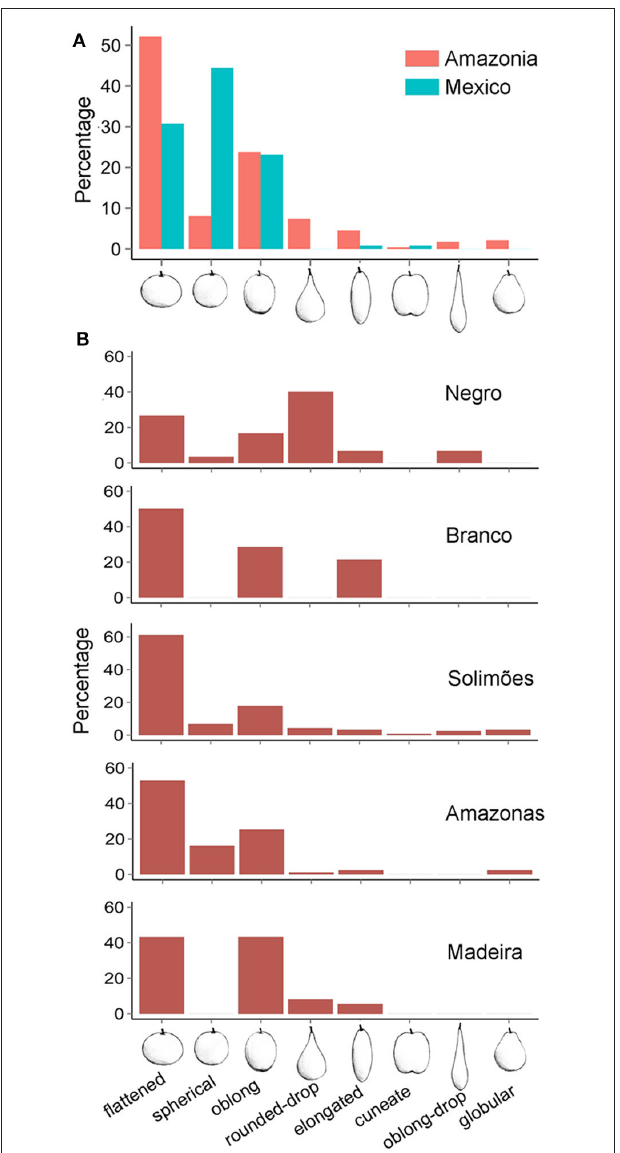
FIGURE 5 | Morphological diversity of cultivated Crescentia cujete in (A) the two domestication centers studied (Mexico N = 117 and Amazonia N = 286) and (B) along Amazonian rivers. Fruit shapes correspond to those described by Arango-Ulloa et al. (2009), except the spherical